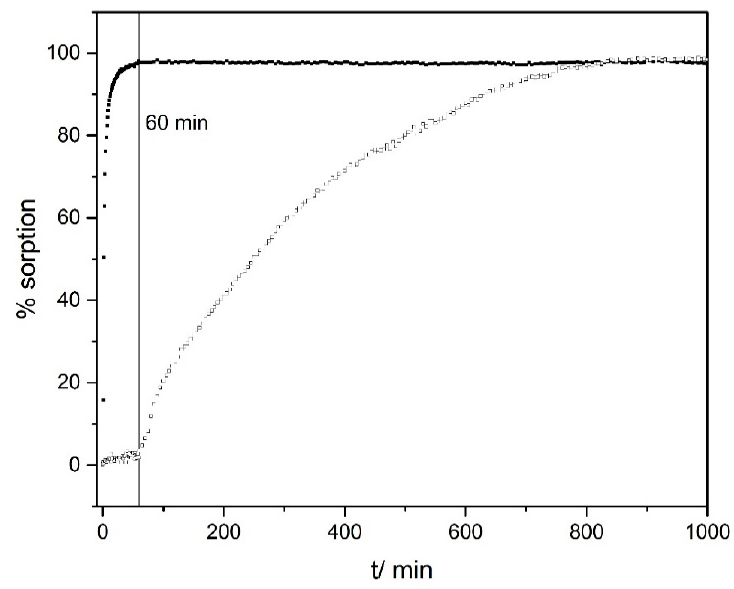
Figure 8. Kinetic profiles of Pb(II) ( □ ) and CV ( ■ ) adsorption onto K10-Mt clay from a mixture.